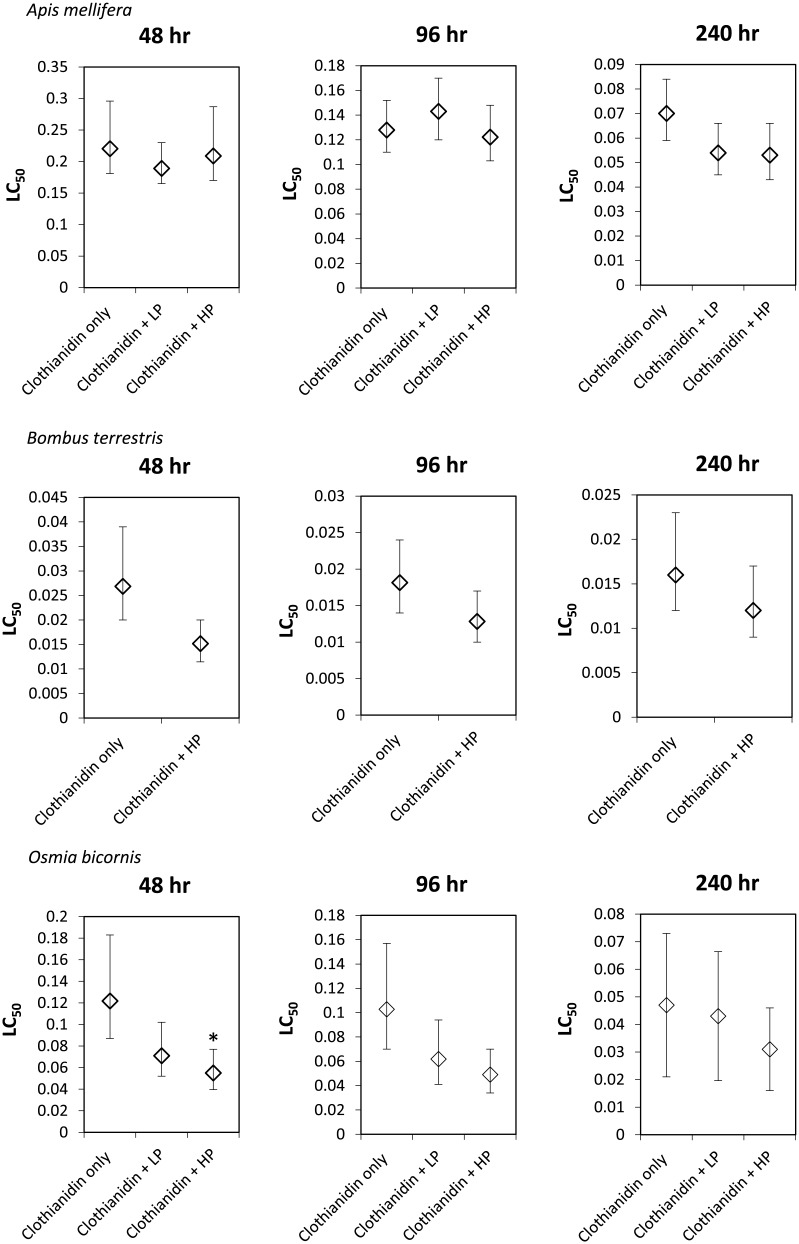
LC50 ± 95% confidence intervals and statistical significance of treatments with propiconazole compared to the propiconazole only series (LC50 ratio test * = p<0.05)for Apis mellifera (top 3 panels), Bombus terrestris (middle 3 panels), and the combined data-set of ♂ and ♀ Osmia bicornis (bottom 3 panels) exposed to clothianidin in the presence of no, low or high concentrations of propiconazole at exposure times of 48 h (Panel 1 of 3), 96 h (Panel 2 of 3) and 240 h (Panel 3 of 3).